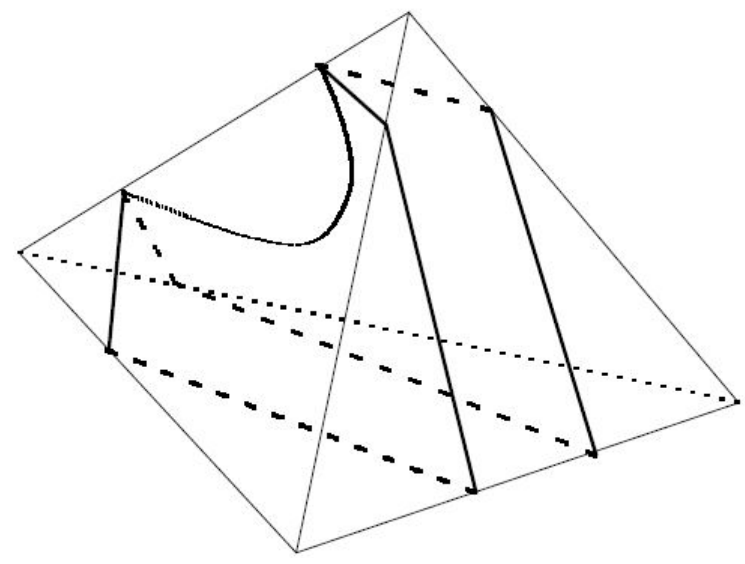
Figure A3. Octagon normal